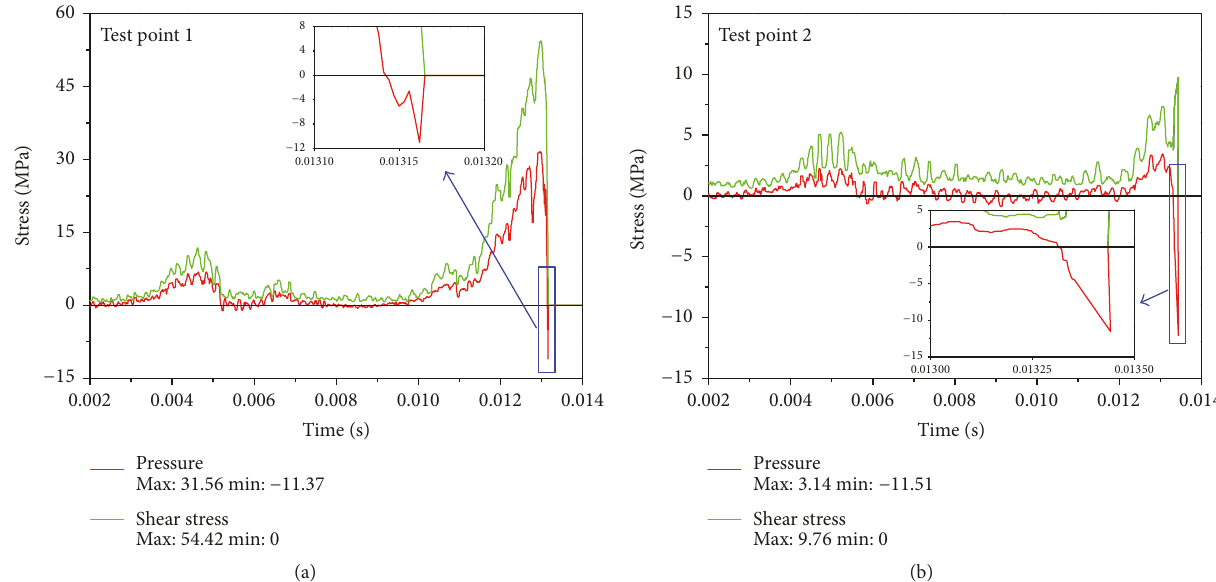
Figure 5: The failure mode of the base rock: (a) the variation in the stress at test point 1 and (b) the variation in the stress at test point 2.